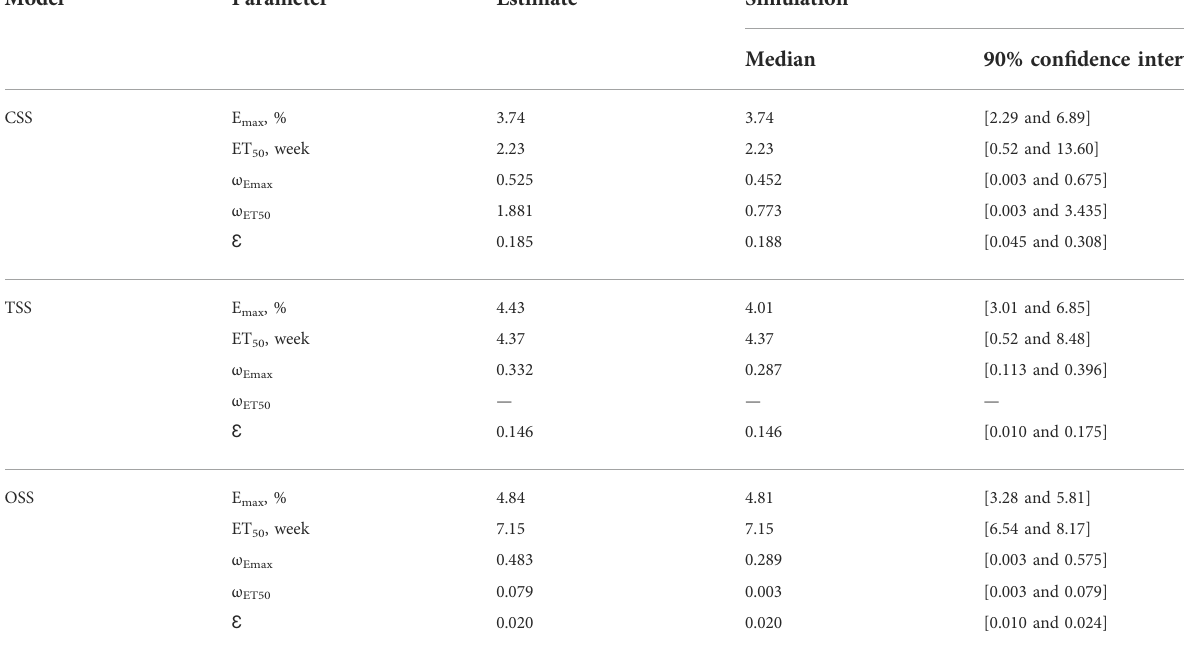
TABLE 2 Parameter estimates of the fi nal model and 90% con fi dence interval.